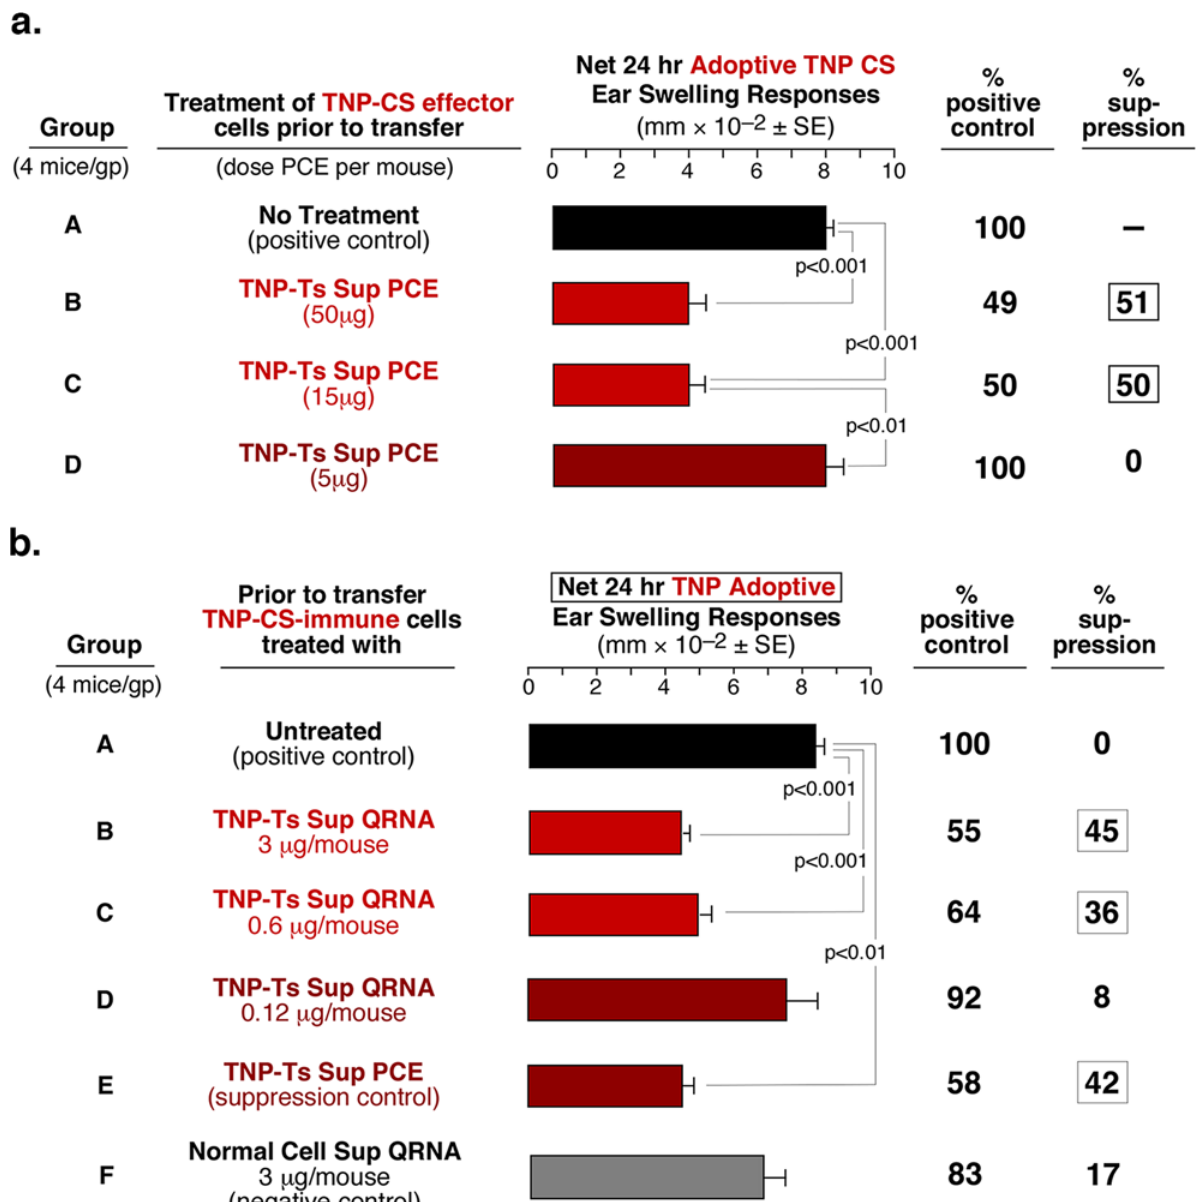
Fig 2. Dose-dependent suppression mediated by PCE and QRNA fractions of TNP Ts Sup. a . Three-fold decreasing doses of TNP Ts Sup-derived PCE regressively suppresses adoptive CS responses down to a dose of 15 μ g per eventual recipient (Groups B and C). b . Five-fold decreasing dose-response of QRNA from TNP Ts Sup PCE results in suppression of adoptive CS responses down to a dose of 0.6 μ g per recipient (Group C).